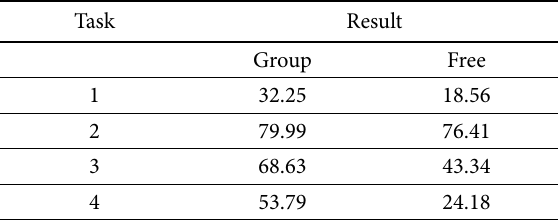
Table 5. Greedy search results for each